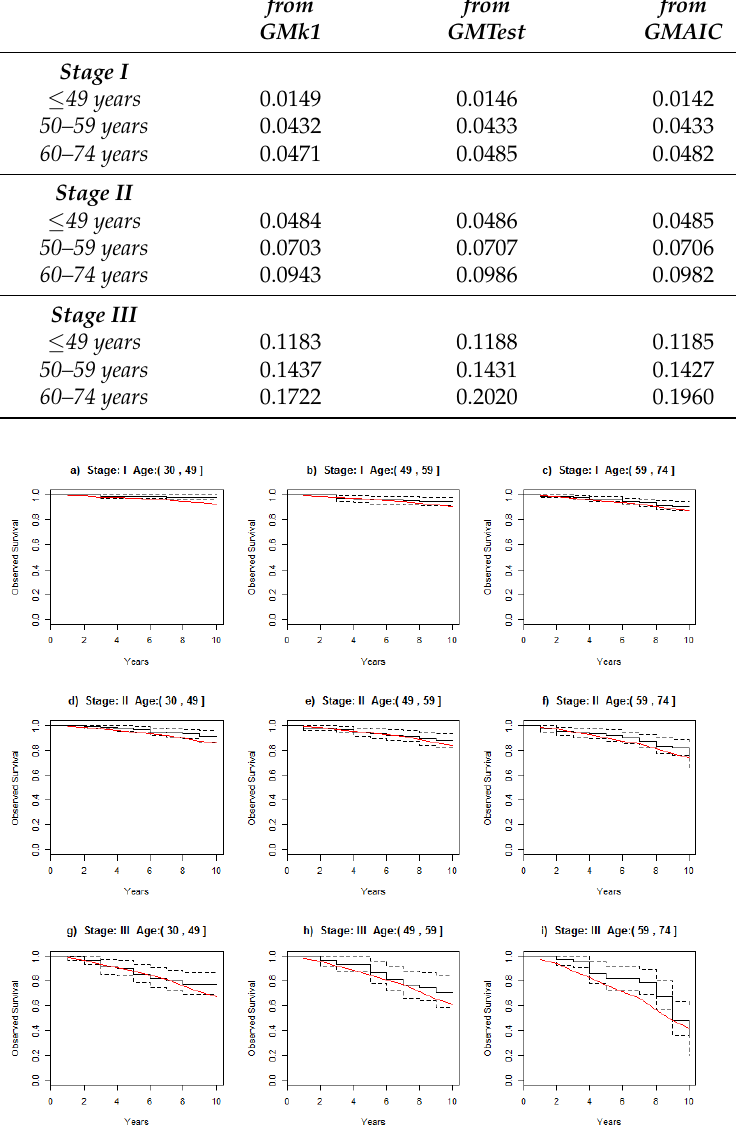
Figure 3. Comparison of 95% credible interval of observed survival derived from original cohort (black) and median survival (red) of combined cohort across stages at diagnosis and stratified by age